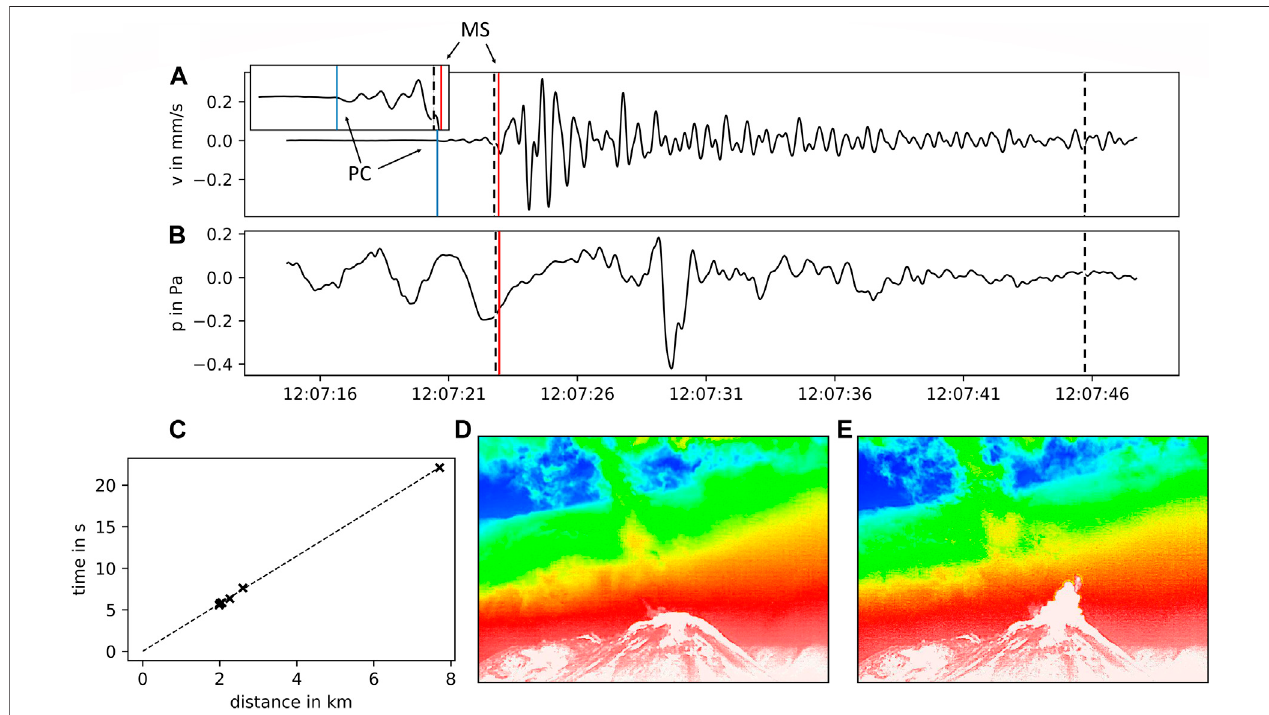
FIGURE 3 | Comparison of acoustic origin time with visual observations of an explosion on 10.01.19. (A) Z-component of seismic signal at LIN3 with enlarged precursor signal (PC) in the inset. The blue vertical line indicates the precursor onset, whereas the main signal (MS) starts directly at the red line. (B) Associated acoustic signal measured at the central array station. Acoustic and seismic data is fi ltered with a fourth-order Butterworth bandpass (0.125 – 3 Hz). In (A) and (B) the red lines indicatetheorigintimeoftheacousticsignalandthedashedlinescorrespondtothethermographicimagesin (D) and (E) ,respectively. (C) Acousticarrivaltimesat different stations vs. their distance to the crater determining the acoustic origin time. The two thermographic images show the fi rst gas emission at the dome (12:07:22, (D) ) and the further gas rise (12:07:45, (E) ).